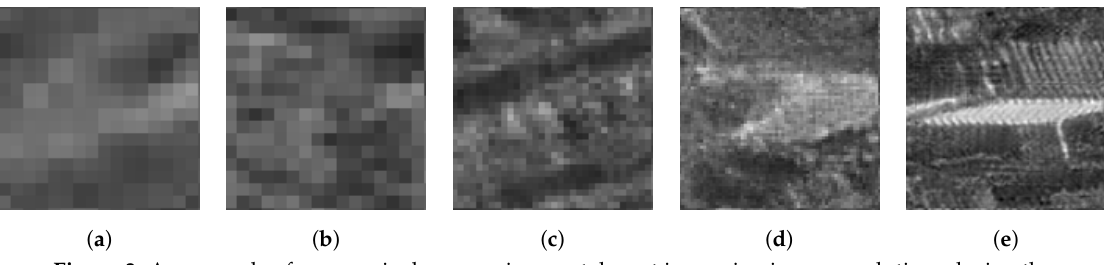
Figure 3. An example of progressively grown images taken at increasing image resolutions during the training processes. ( a – e ) shows the resolution growth from 8 × 8 pixels up to 128 × 128 pixels with the resolution doubling at each